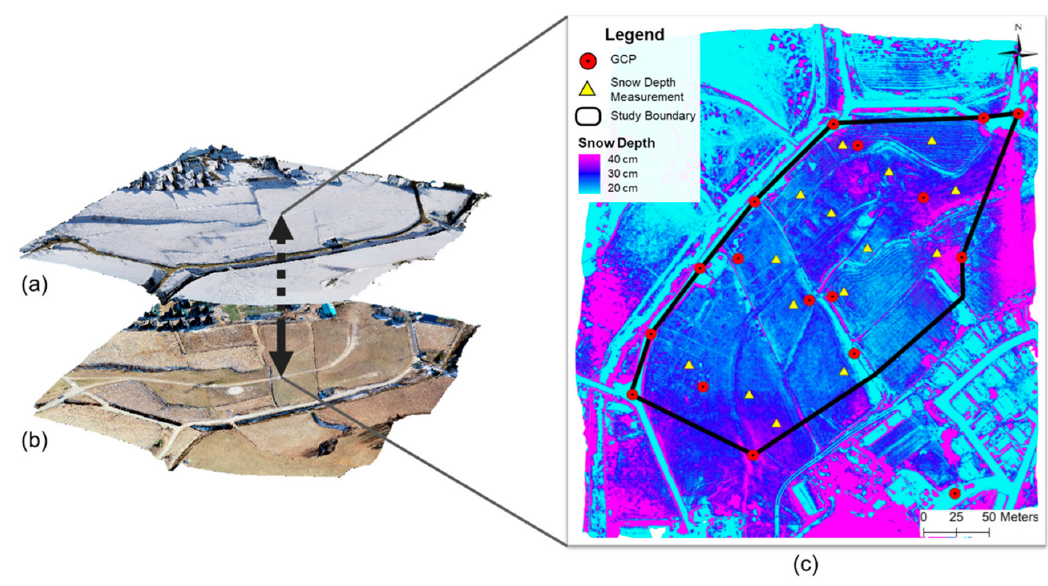
Figure 6. ( a ) Ortho+DSM of snow surface ( b ) Ortho+DSM of the ground surface. ( c ) The snow depth map that was obtained by subtracting the DSM of ground from that of the snow surface (4 February 2020, 9